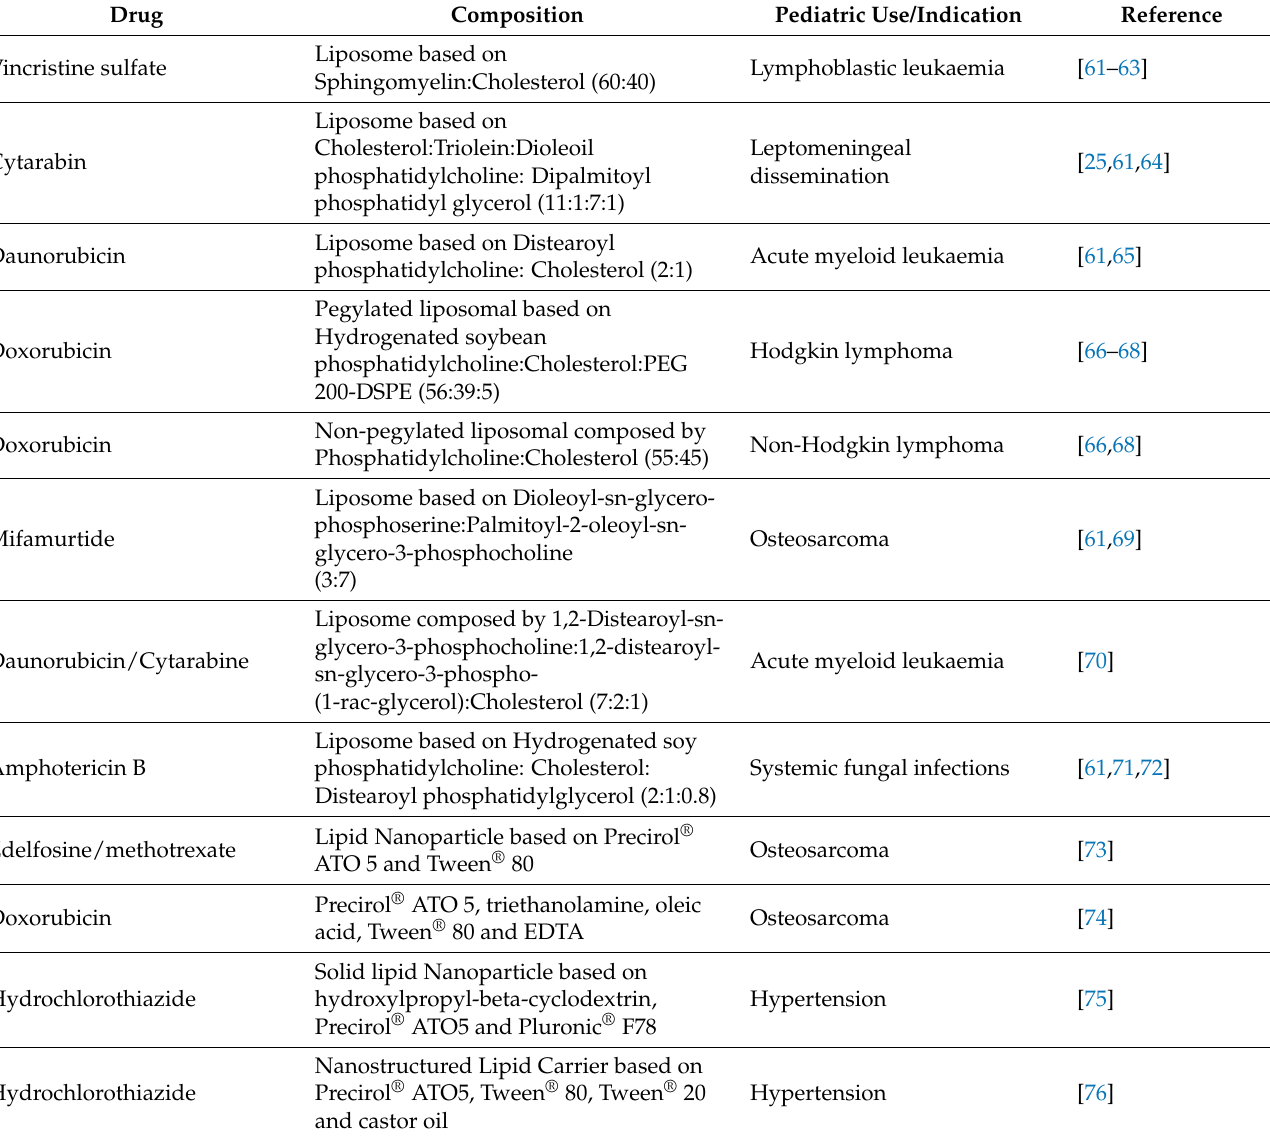
Table 2. Lipid nanoparticles studied as drug carriers in